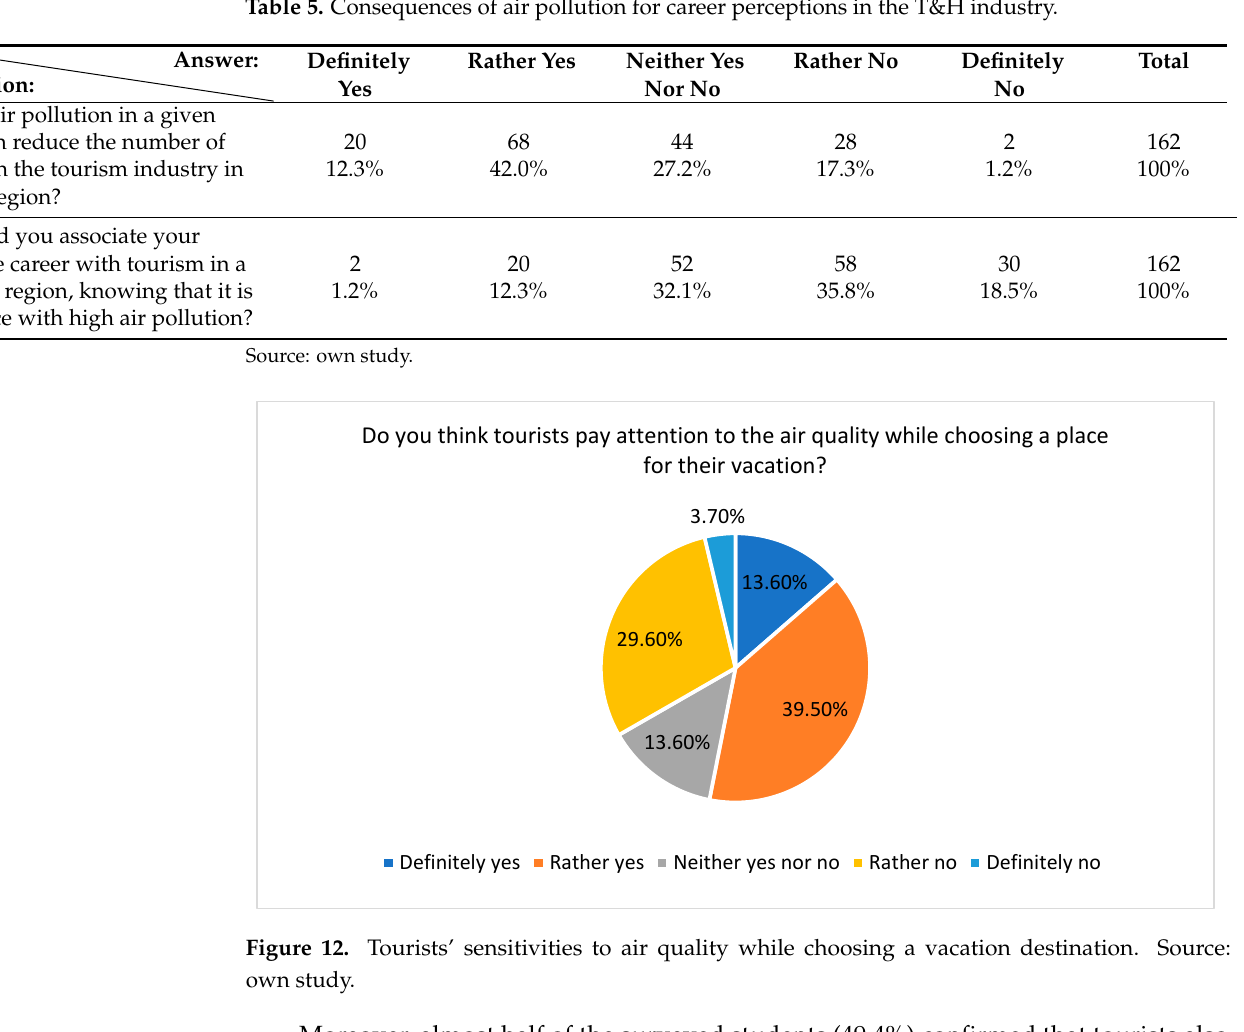
Table 5. Consequences of air pollution for career perceptions in the T&H industry.